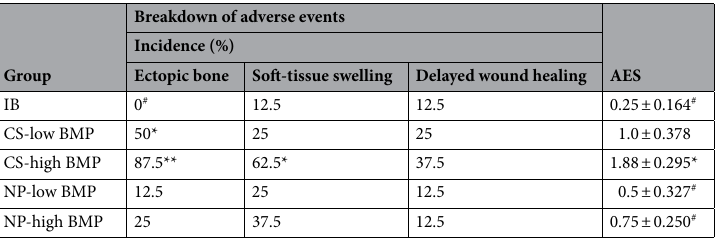
Table 1. Summary of the adverse events. IB iliac bone, BMP rhBMP-2, CS collagen sponge, NP Novosis putty, AES adverse event score. * p < 0.05 (vs. IB group), ** p < 0.001 (vs. IB group), # p < .05, (vs. CS-high BMP group).